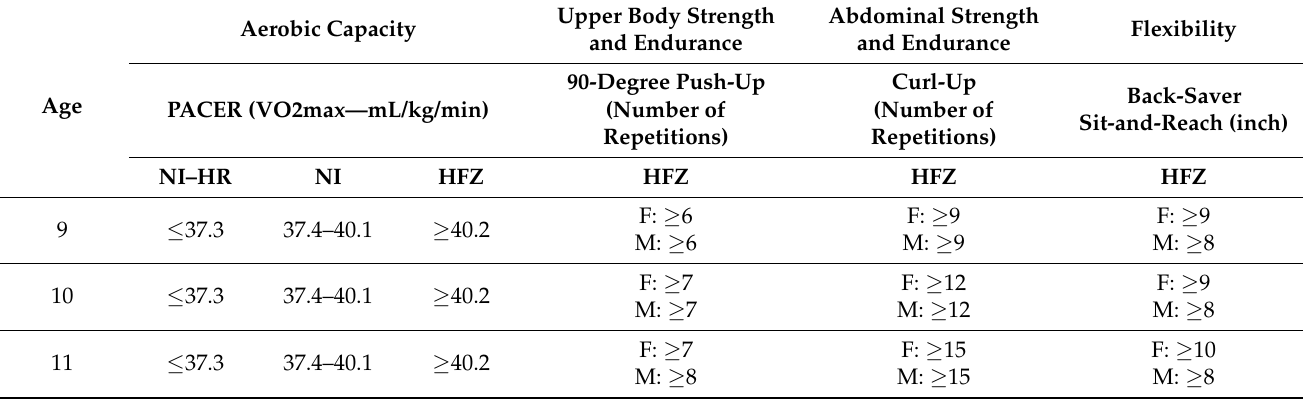
Table 1. FitnessGram Healthy Fitness Zone Performance Standards: Age 9 to 11 [28].